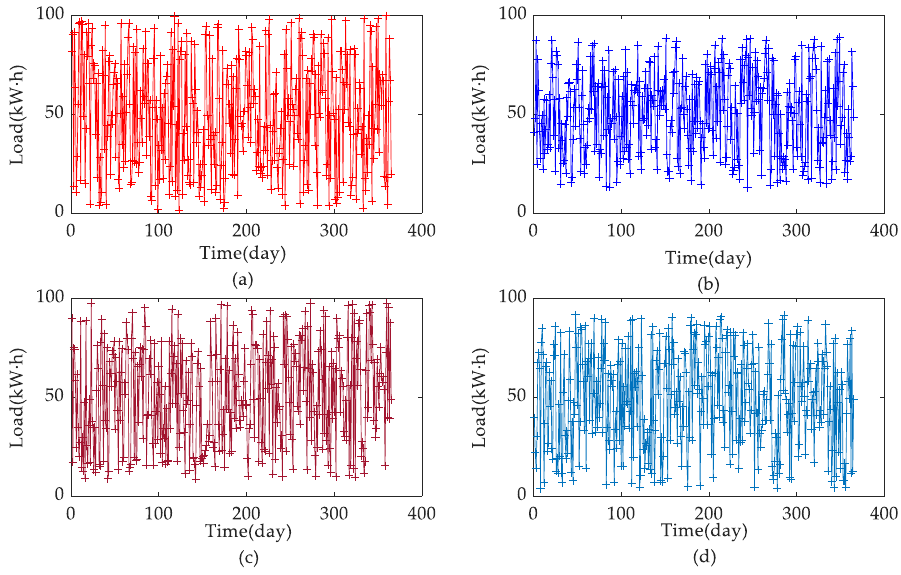
Figure 7. The loss of daily load. ( a ) The daily missing load in 2016; ( b ) The daily missing load in 2017; ( c ) The daily missing load in 2018; ( d ) The daily missing load in 2019.